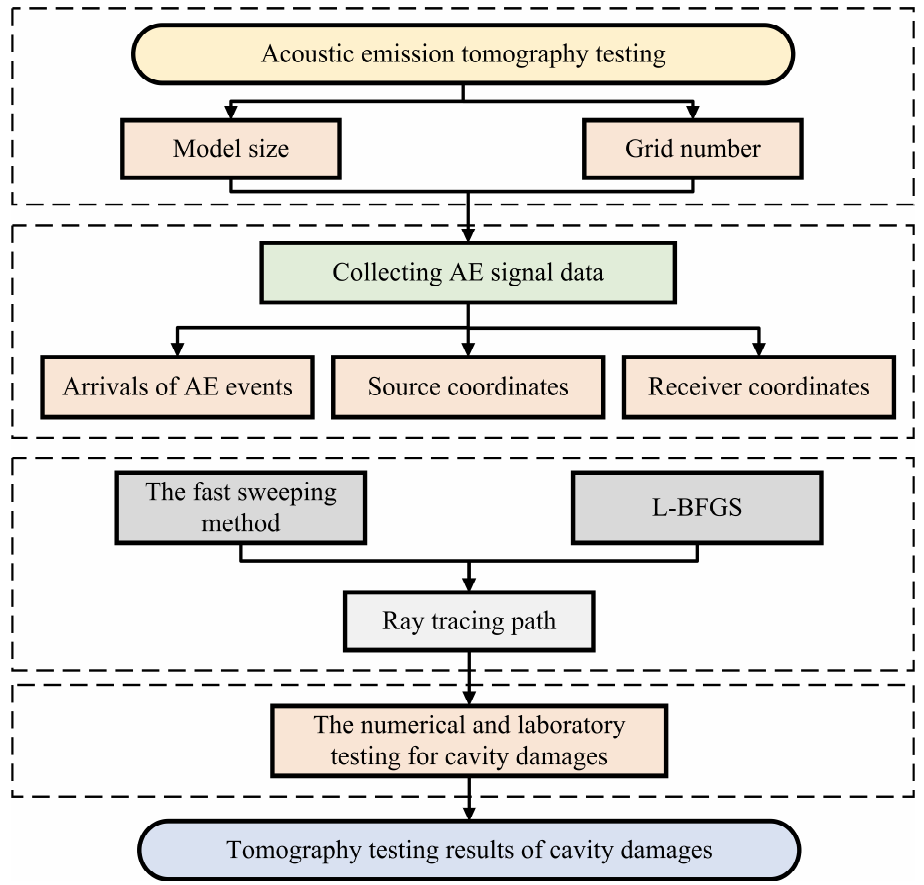
Figure 1. Flowchart of tomography testing for cavity damages. The proposed method utilizes FSM and L-BFGS as the forward modeling and inversion algorithm, respectively.